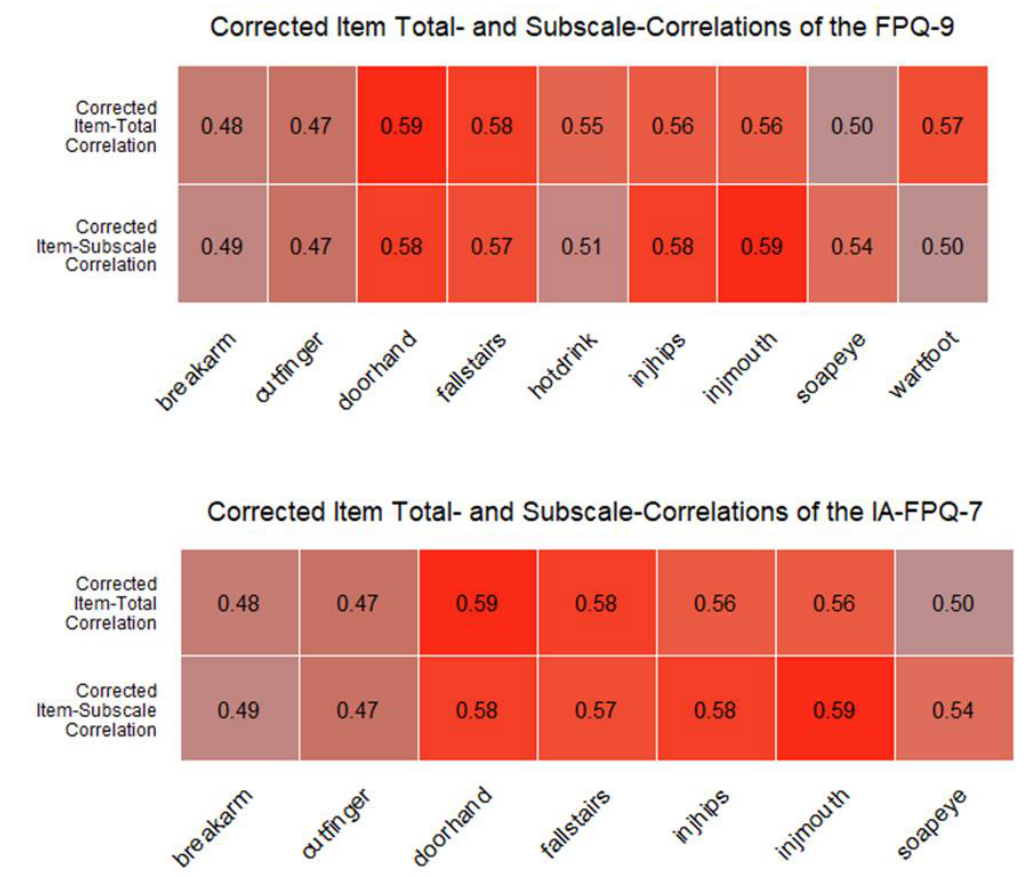
Figure 3. Corrected item total correlations of the FPQ-9 and IA-FPQ-7. Note: The saturation of the colour indicates the strength of the correlation (i.e., stronger shades of red indicate stronger correlations). The analysis of measurement invariance by age showed adequate fit of the configural model. The progressive comparisons between further constrained models showed that: (1) the constrained thresholds model was not statistically different from the configural model ( ∆ χ 2 (14) = 10.31; p = 0.739); (2) the metric model was not statistically different from the constrained thresholds model ( ∆ χ 2 (4) = 0.61; p = 0.961); and (3) the scalar model was not statistically different from the metric model ( ∆ χ 2 (4) = 8.96; p = 0.083), thus